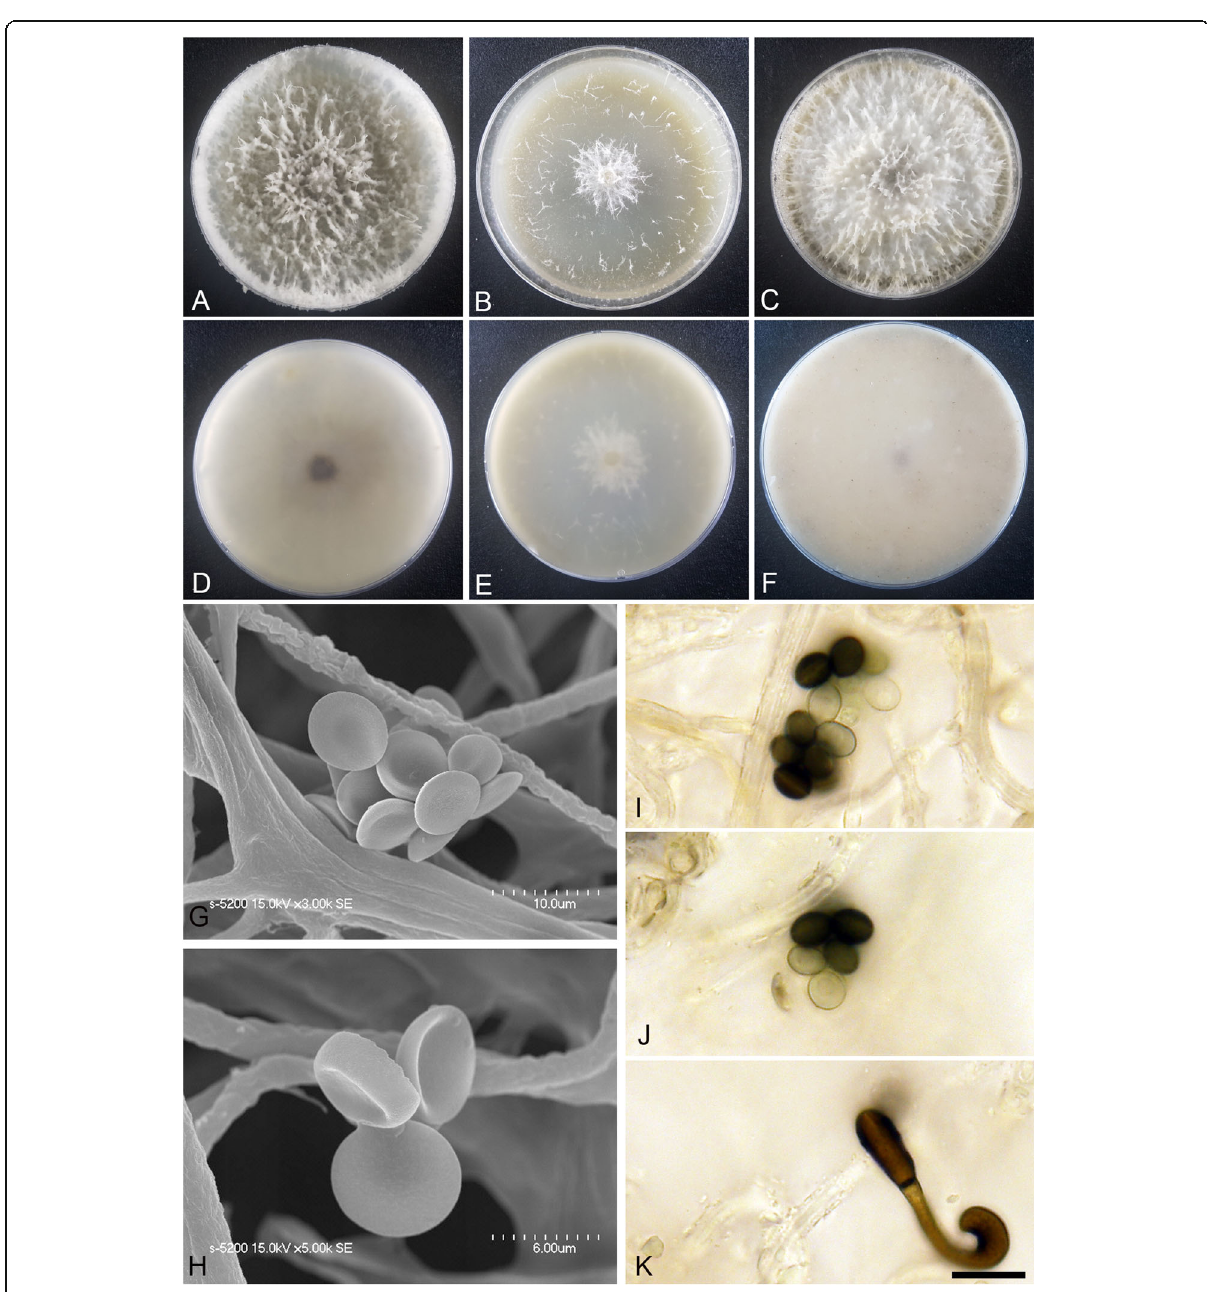
Fig. 10 Arthrinium taeanense (KUC21322). A-C, Colonies on PDA ( a ), MEA ( b ), and OA ( c ) (top); d-f , colonies on PDA ( d ), MEA ( e ), and OA ( f ) (bottom); g-h , conidia under SEM; i-k , conidia attached to conidiogenous cells; scale bar = 10 μ